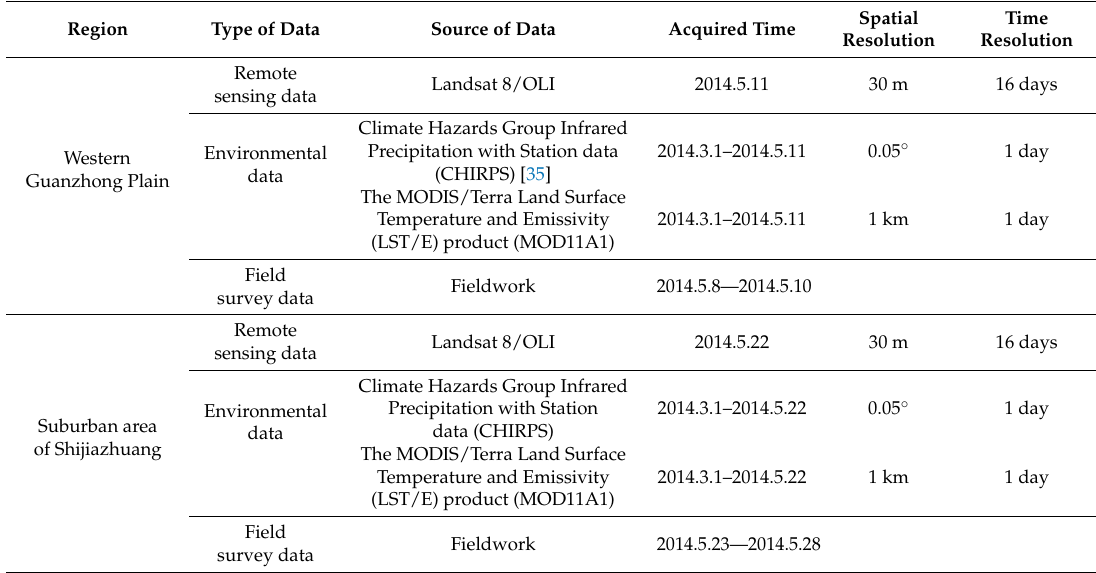
Table 1. Data used in the